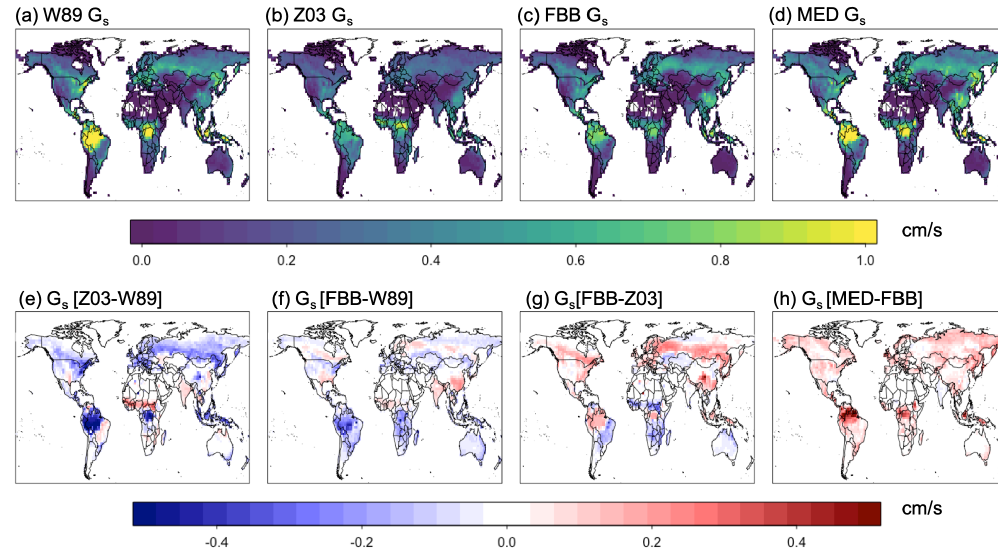
Figure 11. Simulated average daytime G s with different stomatal schemes for 2010–2014 July.